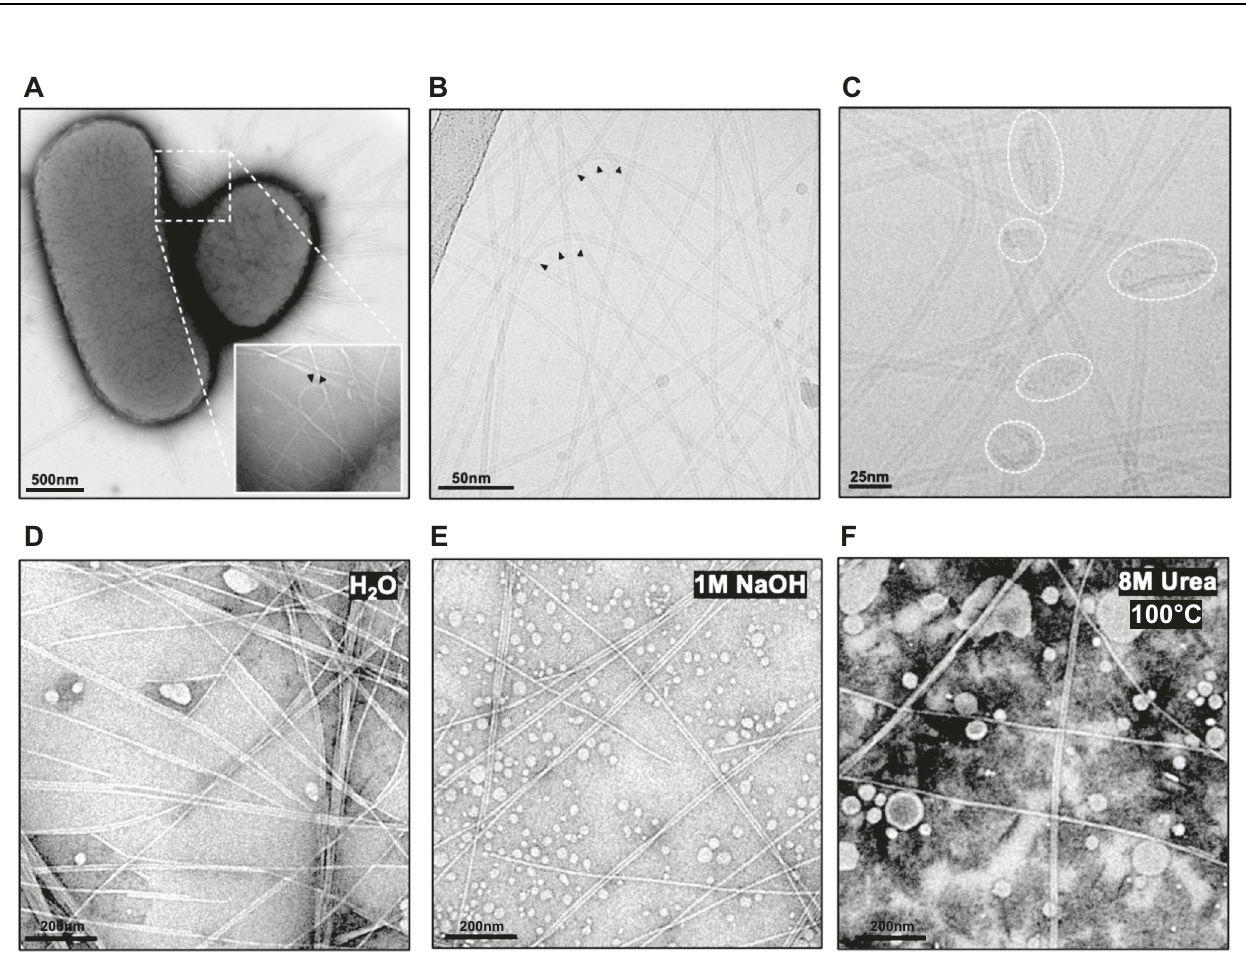
beads *** p =0.0002. Data were obtained from n=6 biological replicates. C Bio fi lm formationabilityobtainedafter24hgrowthoftwodonorstrainsDH5 α (F + )andEDL 933 (F + ) and two plasmid-cured strains DH5 α (F − ) and EDL 933 (F − ) with recipient strain DH10 β (F − ), as described for conjugation ability. All p-values were derived from comparisons of each condition via two-way ANOVA with Tukey ’ s correction formultiplecomparisons.DH5 α F − /DH10BF − glassbeadsvsDH5 α F + /DH10BF − glass beads p =0.0003; EDL933 F − /DH10B F − glass beads vs EDL933 F + /DH10B F − glass beads* p =0.0106.All p valuesdenoted as****were p <0.0001. Datawereobtained from n =3 biological replicates measured in triplicate. Negative stain images for chosenconditionswerepresentedbelowasanexampleoftheF-pilusmediatedcell aggregation. **** p <0.0001; *** p <0.001; ** p <0.01; * p <0.05; ns not signi fi cant. Bars in all graphs represent mean values, whiskers represent standard deviation, and black circles represent each replicate value. A cartoons were created with BioRender.com. Source data are provided as a Source data fi le.